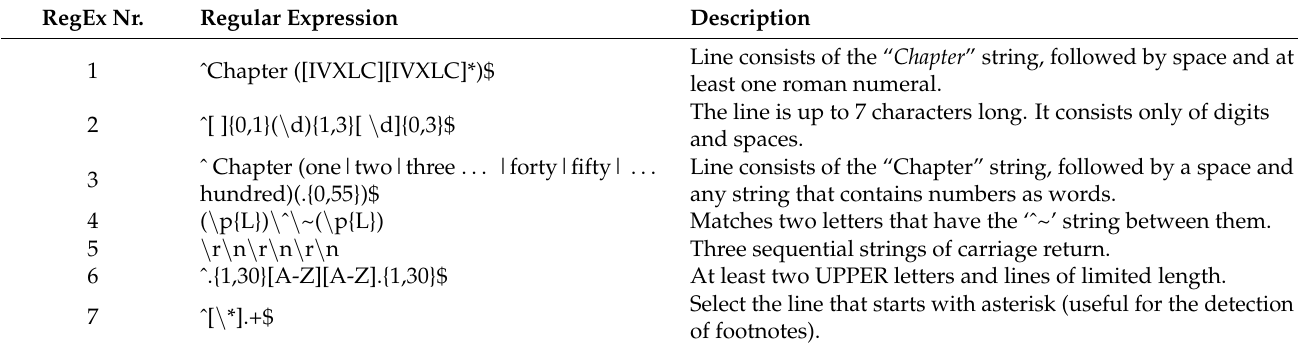
Table 1. An example of a small subset of regular expressions used to identify some fragments in a text. RegEx Nr. Regular Expression